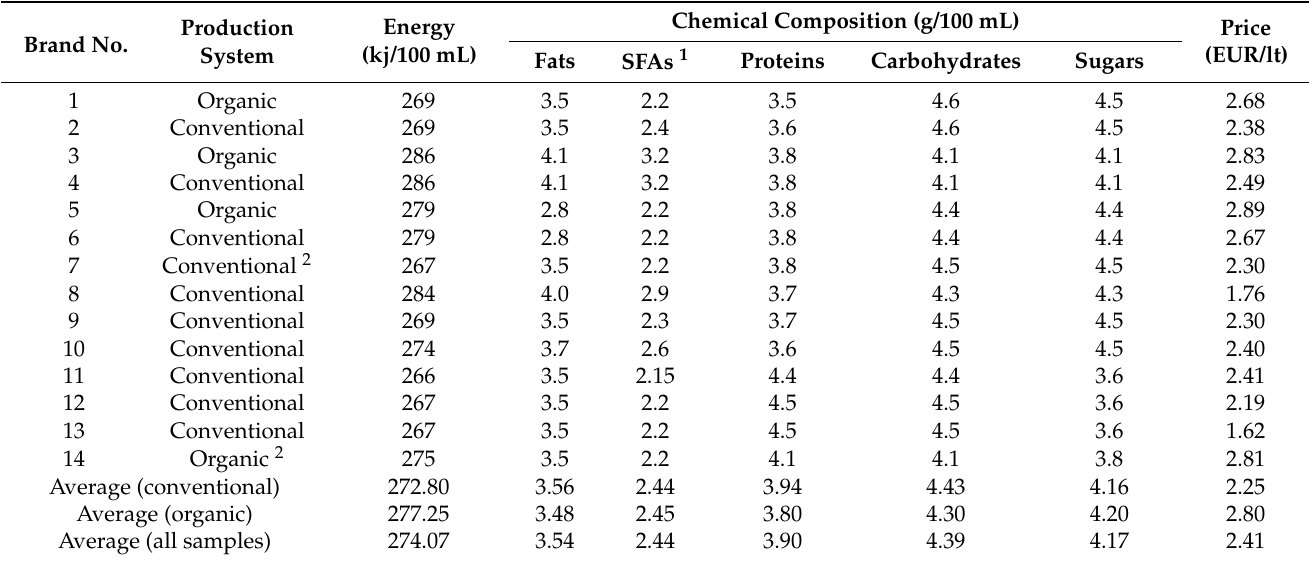
Table 3. Declared energy (kj/100 mL), chemical composition (g/100 mL) and price (EUR/lt) of retail goat milk purchased in Greece in 2019–2020 for 12